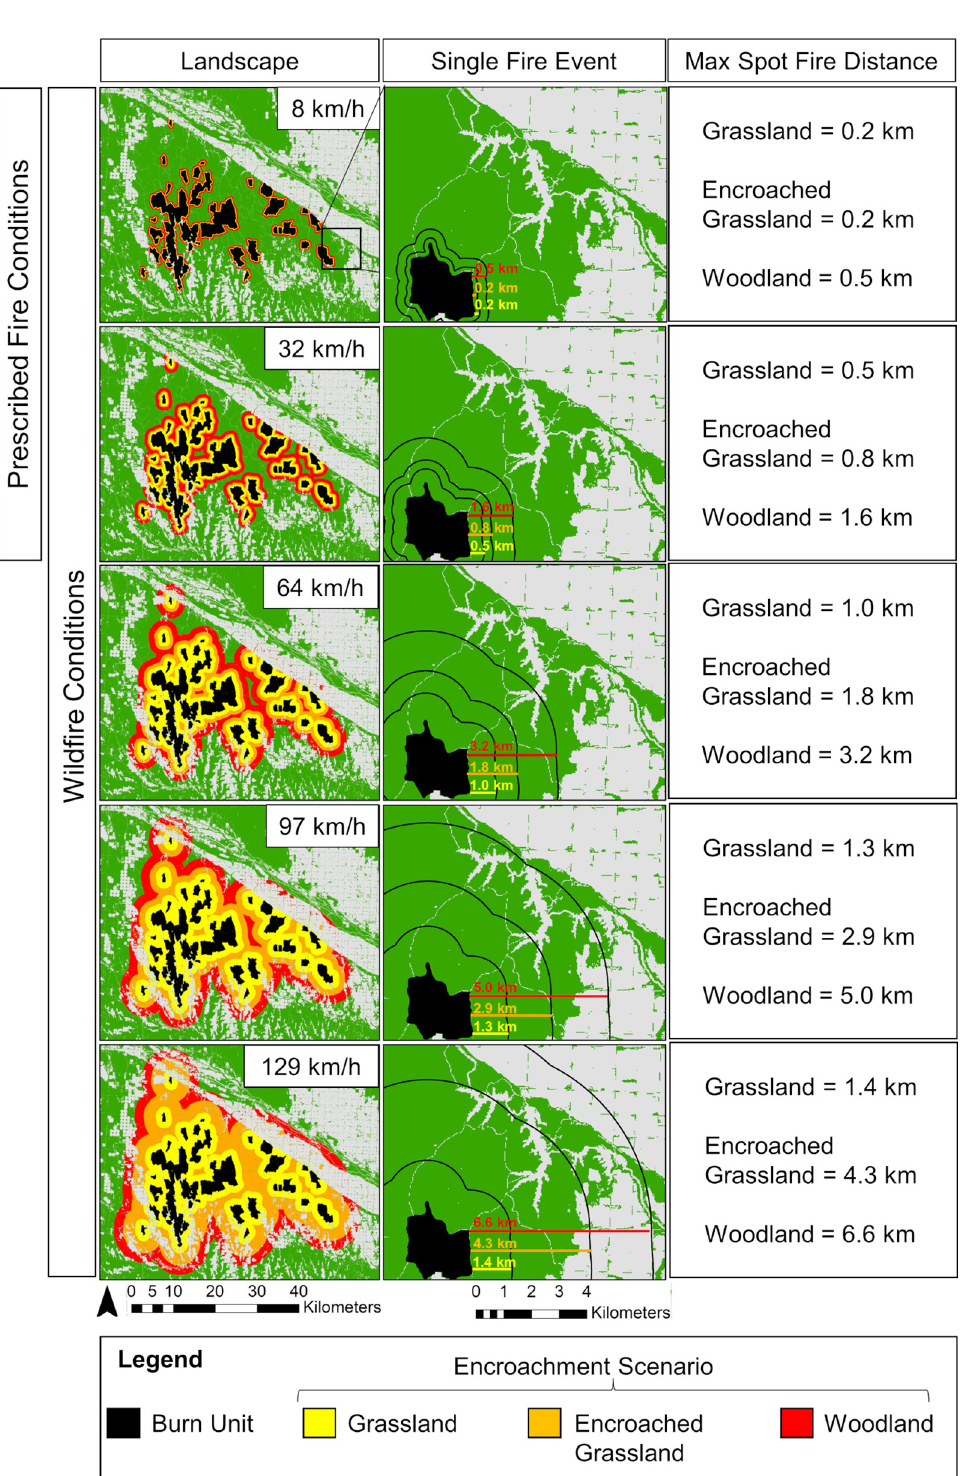
Fig 3. A comparison of maximum potential spot fire distance under prescribed fire (8 and 32 km/h) versus wildfire (8, 32, 64, 97, and 129 km/h) wind speeds relative to the grassland state (yellow), juniper encroached grasslands (orange), and the juniper woodland state (red) in the Loess Canyons Experimental Landscape. Column 1 shows a landscape representation of changes in the potential exposure of receptive fuels relative to maximum spot fire distance from burn units in the Loess Canyons if they were all grassland (yellow), all juniper encroached grassland (orange),